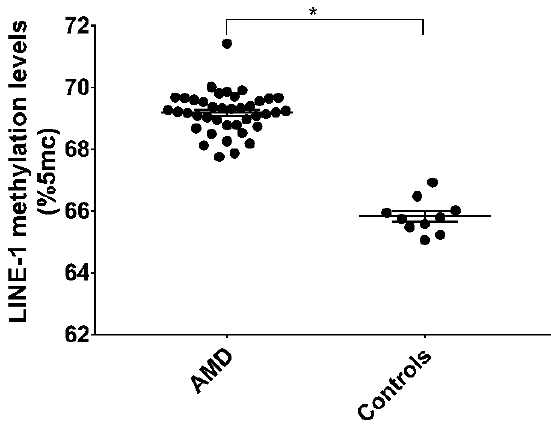
Figure 3. LINE-1 methylation levels in AMD patients ( n = 40) and age- and sex-matched controls ( n = 10). * p < 0.05 vs. controls based on the Student's t -test. LINE-1, Long Interspersed Nuclear Element-1.